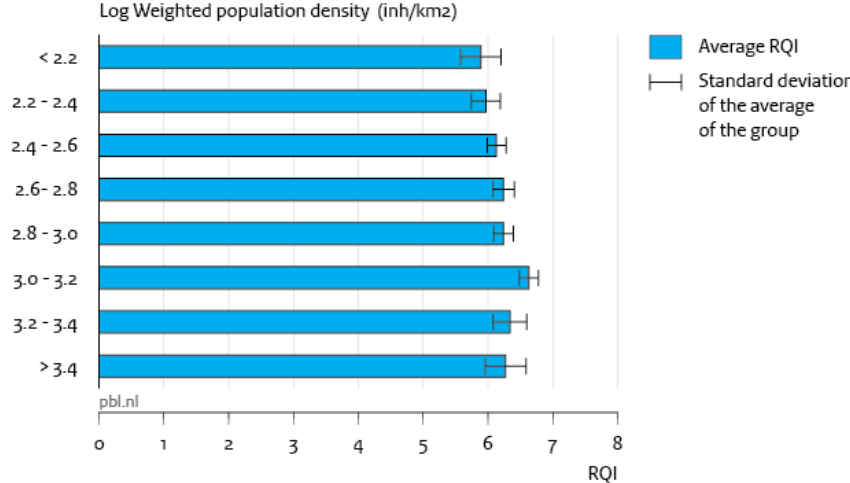
Figure 6: Average scores for Regional Quality of Living indicators for different levels of weighted population density